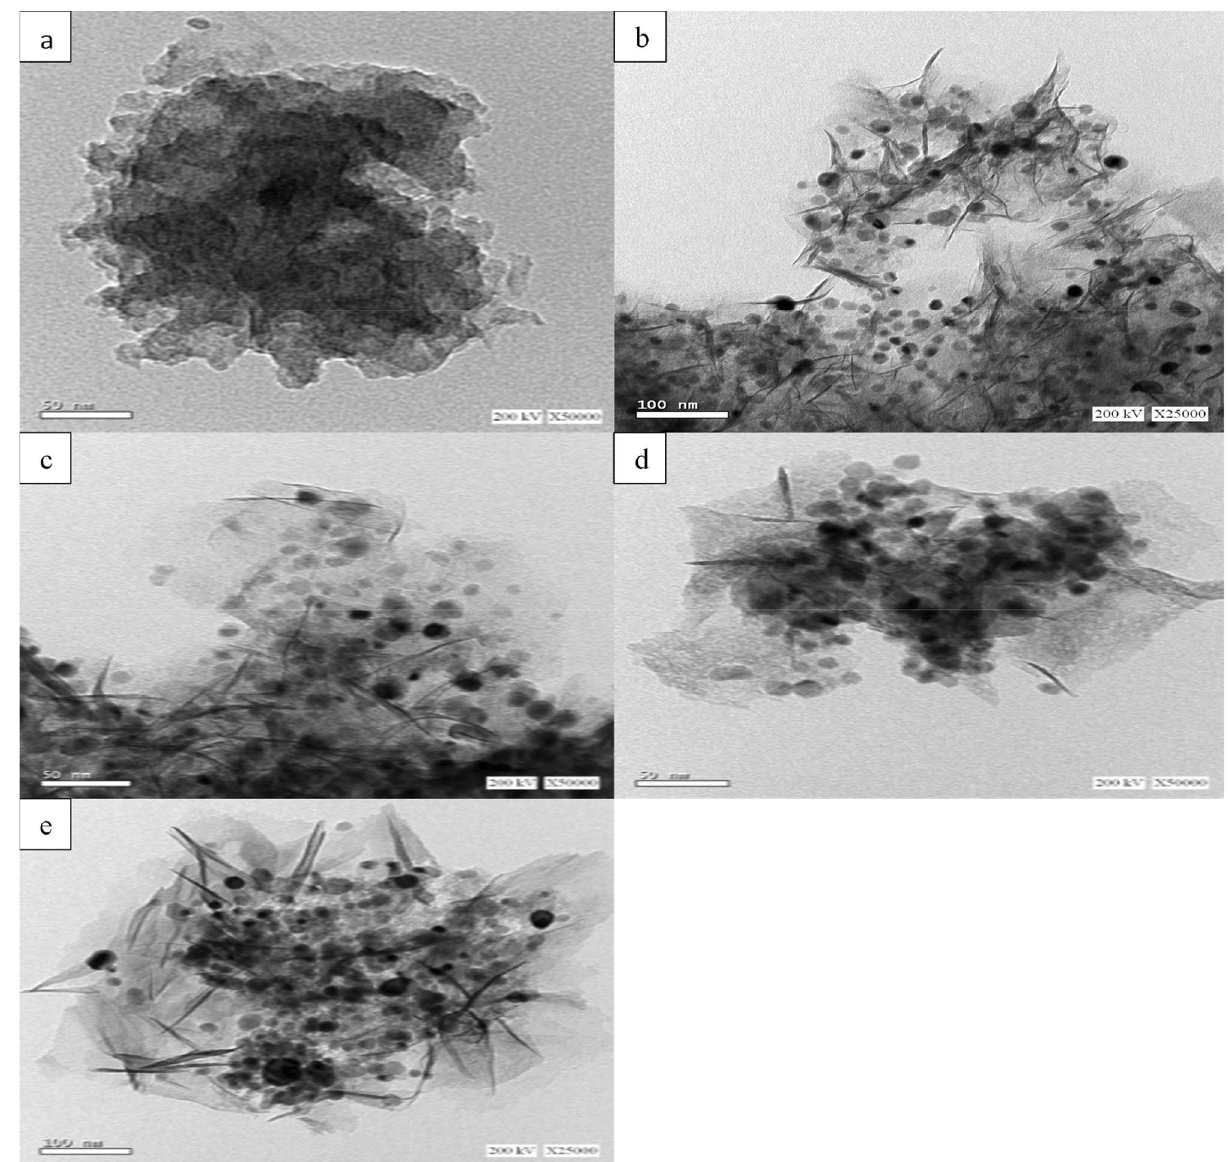
Figure 3. TEM images of ( a ) MCN, ( b ) 5% Ni/MCN, ( c ) 10% Ni/MCN, ( d ) 15% Ni/MCN and ( e ) 20% Ni/